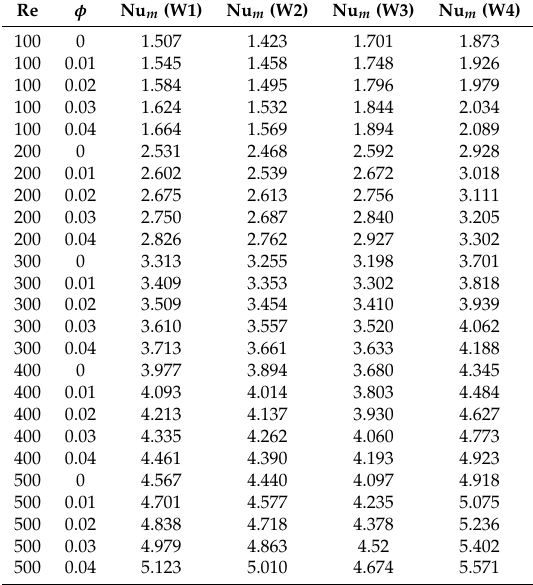
Figure 3. Variation of the local Nusselt number for the upper walls of the horizontal and vertical channels with respect to change in Reynolds number (Ha = 1, φ = 0.02): ( a ) W2, local Nusselt number variation; and ( b ) W4, local Nusselt number variation. Table 5. Effects of Reynolds number and solid particle volume fraction combination on the variation of average Nusselt number for hot walls of the branching channel (Ha =